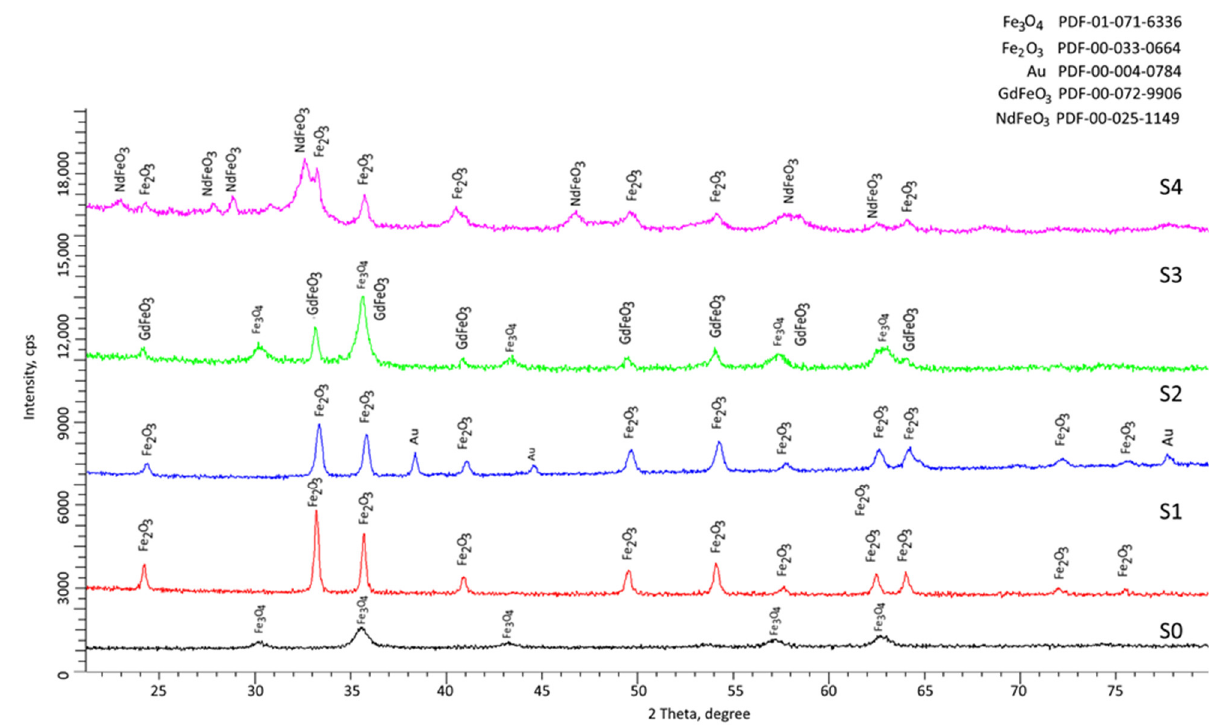
Figure 1. Results of X-ray diffraction of the studied nanoparticles.